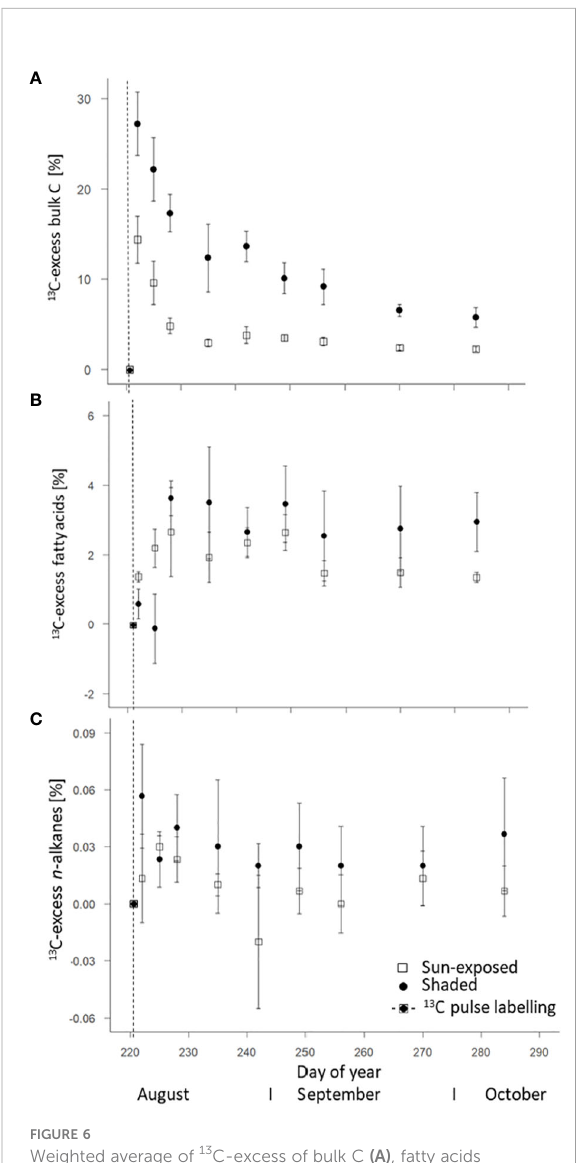
The 13 C-excess of both, sun-exposed and shaded leaves was calculated based on the 13 C/ 12 C ratio from the fi rst leaf sample at time t=0 of the respective branch. The maximum 13 C-excess was